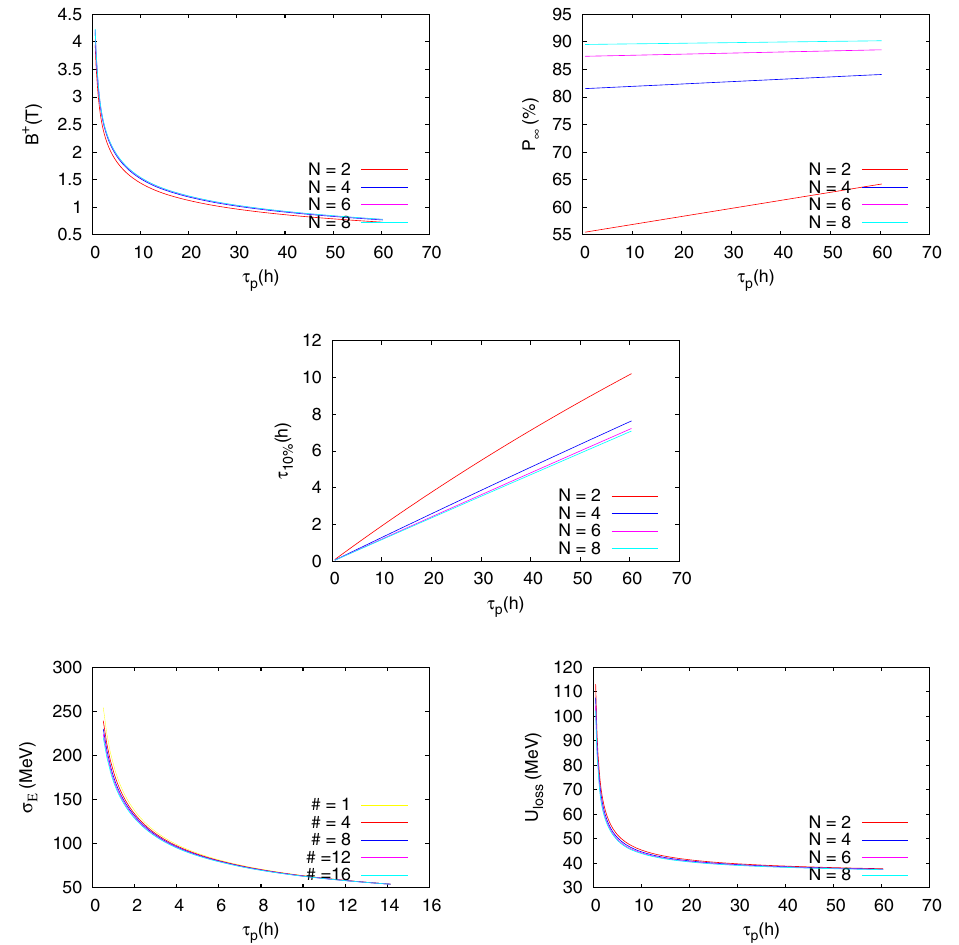
FIG. 2. Parameter values vs. polarization time for one wiggler at 45 GeV for various values of N . Top left: B þ . Top right: Asymptotic polarization. Center: τ 10% . Bottom left: Energy spread. Bottom right: Energy lost per